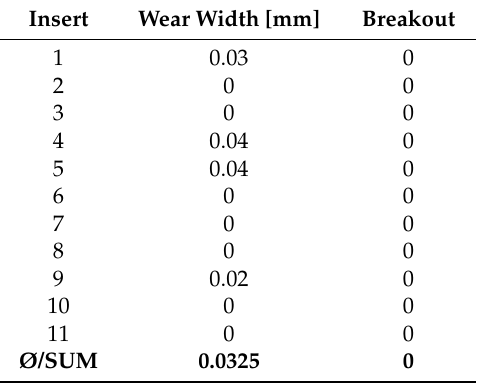
Table 17. Tool wear for each insert after hard machining tests with special inserts of type 1010.